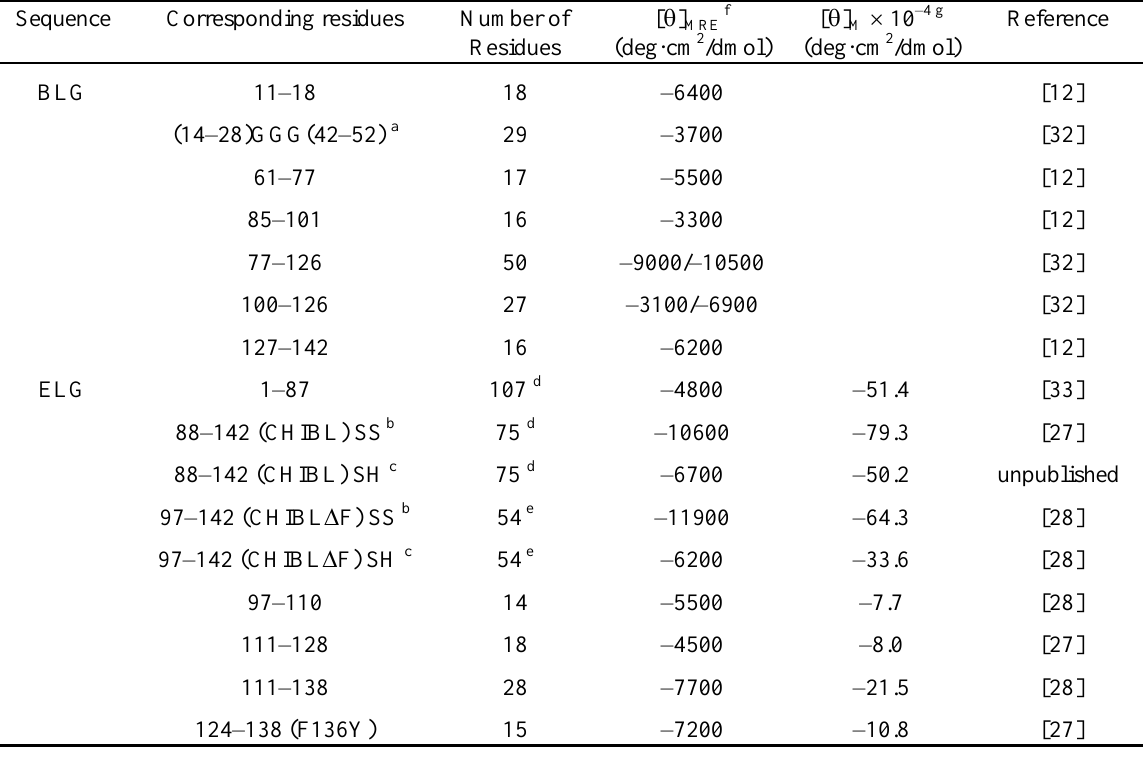
Table 1. Ellipticity values of peptide fragments of  -lactoglobulin at 222